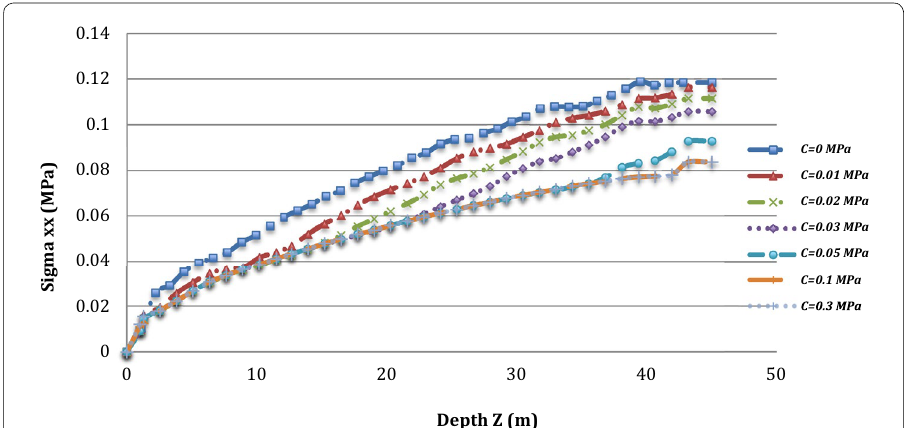
Fig. 7 Effects of cohesion (c) of the backfill on horizontal stress (sigma xx) in a stope measuring 6